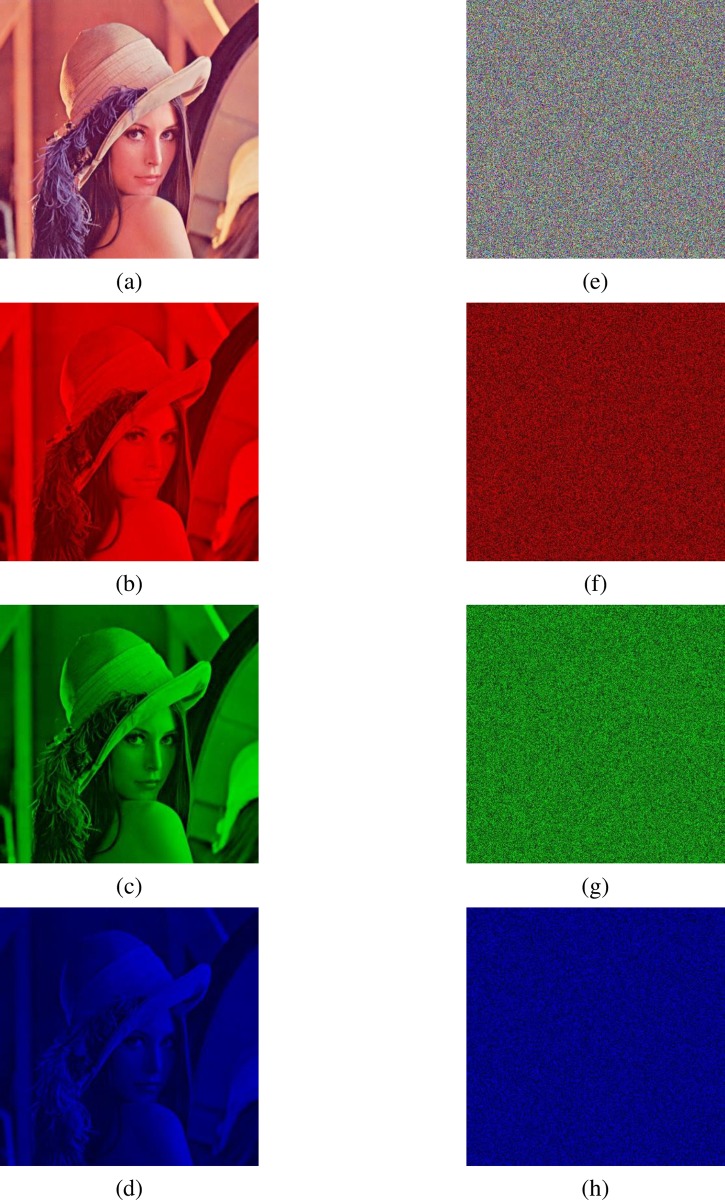
Plain and encrypted layer wise images of Lena.(a) plain Lena image. (b) Red component. (c) Green component. (d) Blue component. (e) Encrypted Lena image. (f) Encrypted Red component. (g) Encrypted Green component. (h) Encrypted Blue component.